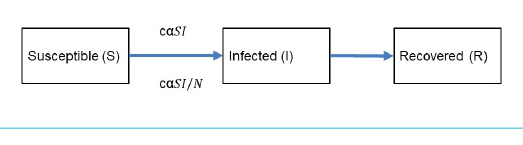
Figure 2: Flow chart of the transmission of an infectious disease in a given population.